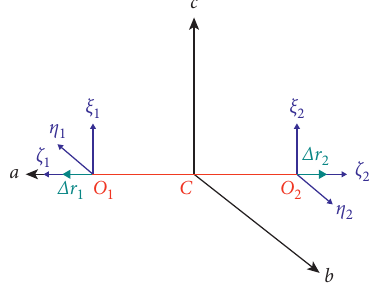
Figure 2: Molecular coordinate system of CO